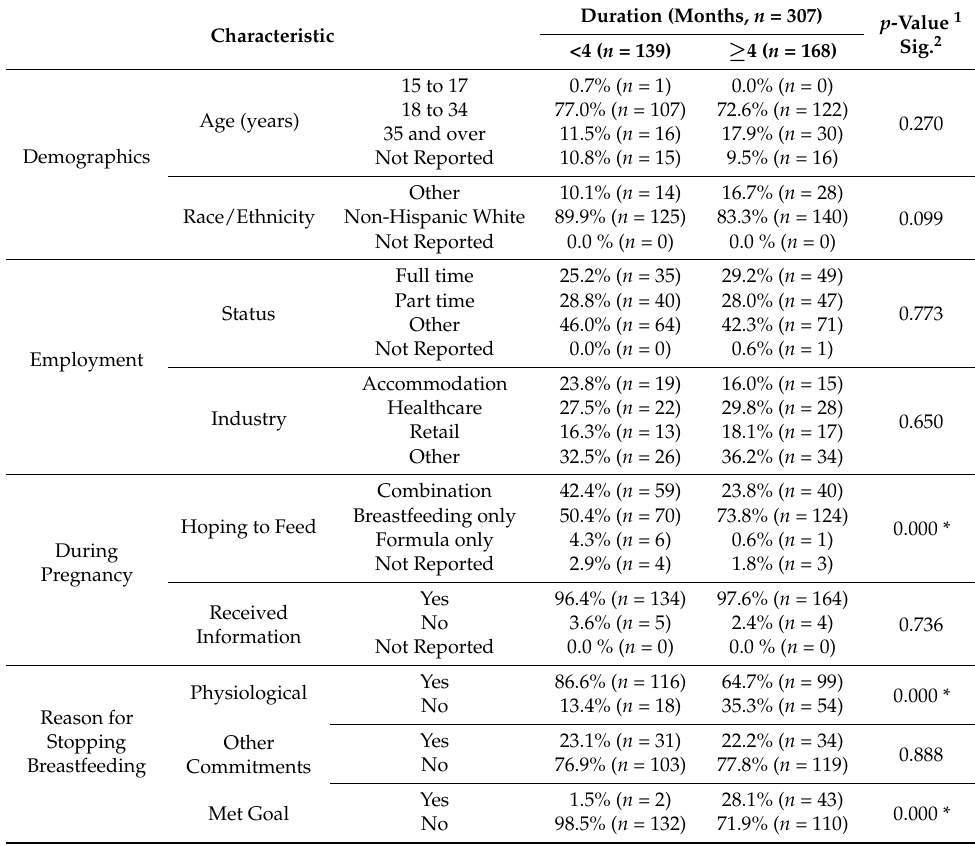
Table 3. Maternal Demographic, Employment, Pregnancy, and Breastfeeding Characteristics by Duration of Breastfeeding (<4 Months vs. ≥ 4